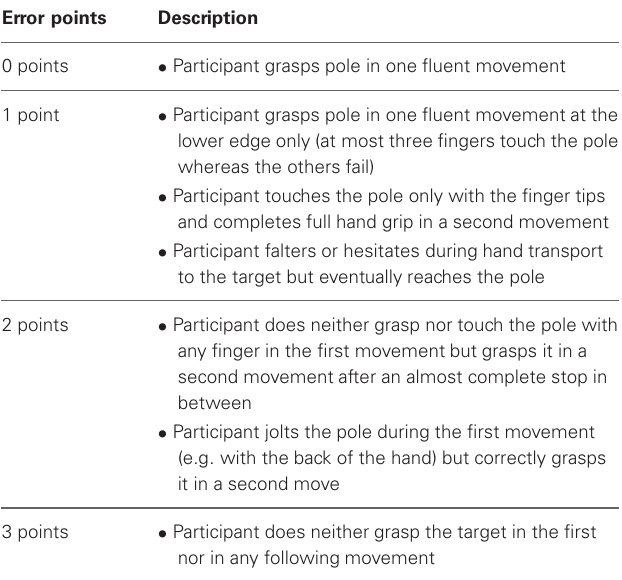
Table 2 | Guidelines for scoring the performance on the OA test. Error